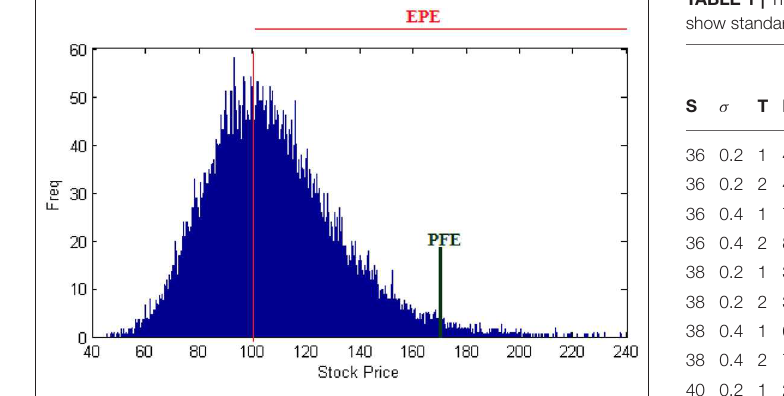
FIGURE 1 | Undiscounted EPE and PFE for a 1 year Euro Call Option.